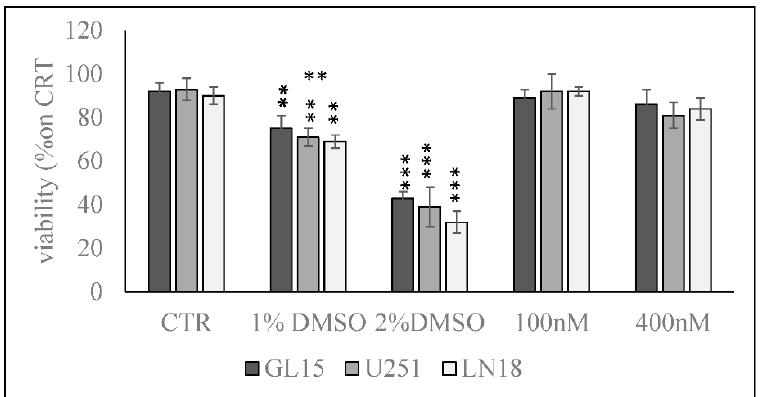
Figure 1. Effect of 1 α ,25(OH) 2 VD3 on GL15 U251, and LN18 cell viability. Cells were cultured with 100 and 400 nM 1 α ,25(OH) 2 VD3 for 24 h, and the viability was measured by MTT assay. Values are reported as the percent of viability compared to the control sample (CTR); 1% DMSO and 2% DMSO were used as positive controls. The data were expressed as mean ± SD of three independent experiments performed in duplicate. Significance, ∗∗ p < 0.01, ∗∗∗ p < 0.001 versus the CTR sample.